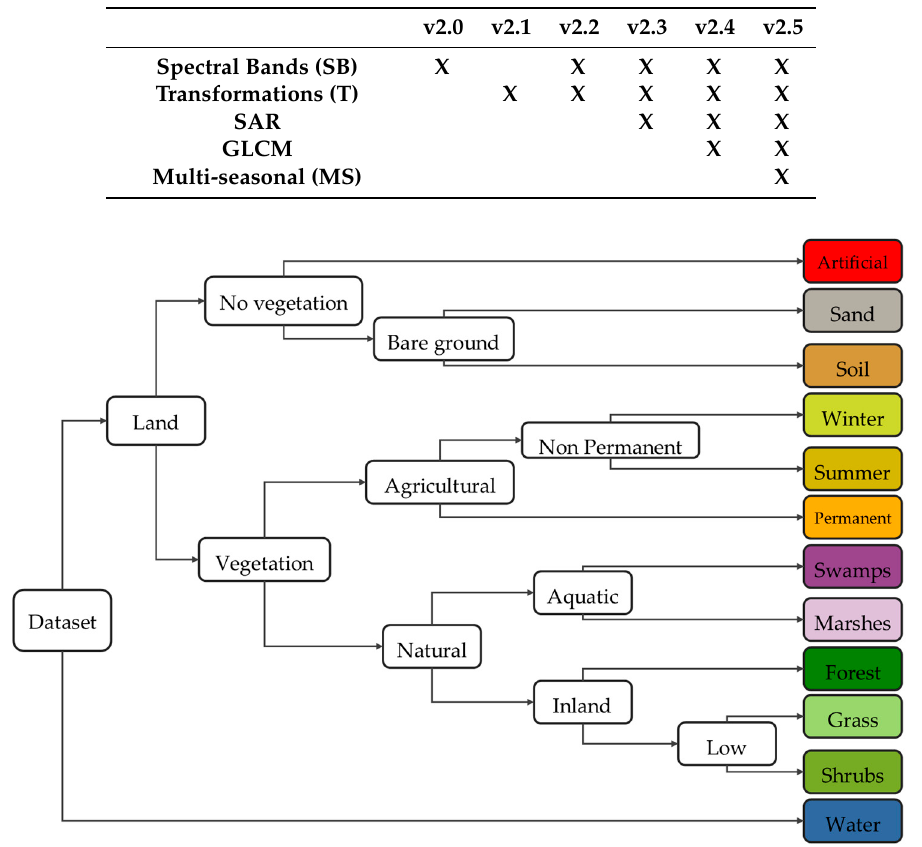
Table 4. The different scenarios tested were grouped in six main thematic categories.